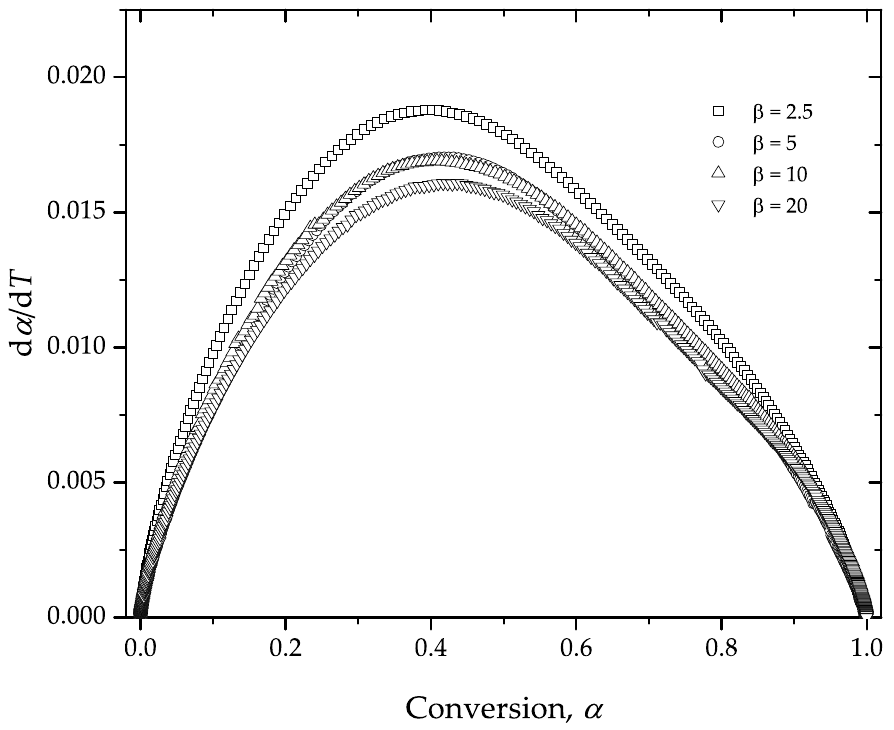
Figure 4. The curing rate corresponding to the crosslinking of a partially bio-based epoxy resin as a function of the conversion, α , for different heating rates, β .